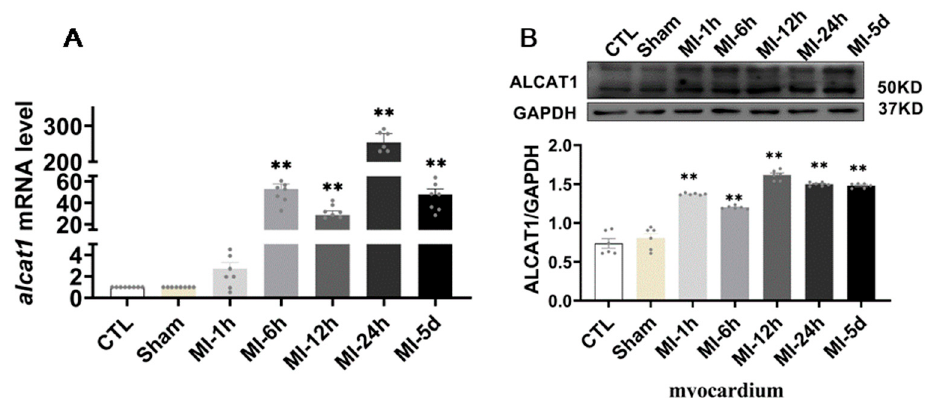
Figure 2. The expression of ALCAT1 mRNA and protein. ( A ) Quantitative reverse transcription polymerase chain reaction (RTq–PCR) analysis of ALCAT1 in the heart ( n = 3). ( B ) Western blot images and densitometric quantitative analysis of ALCAT1 protein expression in the heart ( n = 4). Values presented are the means ± SEM. CTL, normal control; sham; MI-1 h, 1 h after myocardial infarction; MI-6 h, 6 h after myocardial infarction; MI-12 h, 12 h after myocardial infarction; MI-24 h, 24 h after myocardial infarction; MI-5d, 5 days after myocardial infarction (** p < 0.01 vs. sham).